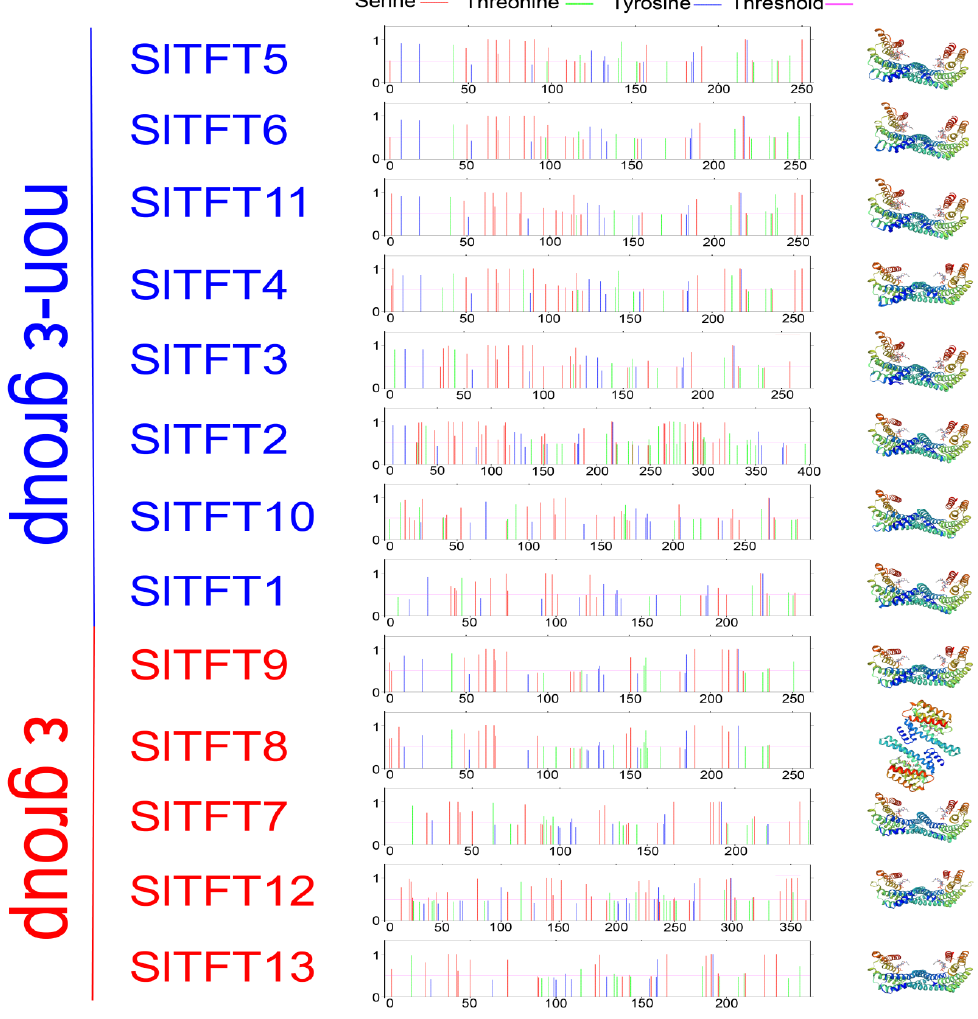
Figure 1. The predicted phosphorylation sites and protein tertiary structure prediction of SlTFTs. The vertical red, green, and blue lines in the middle graph represent the predicted phosphorylation site scores for serine, threonine, and tyrosine, respectively. The horizontal pink line represents the average of the predicted score threshold of 0.5. The gradient colors in the tertiary structure of the protein on the right indicate amino acids from the N-terminal to the C-terminal, different helices, and folded regions with color transitions from blue to red colors.